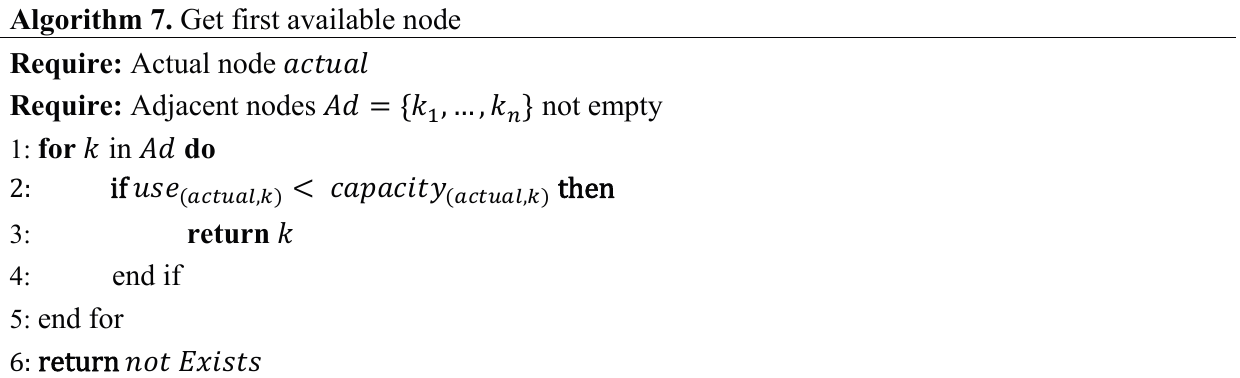
Algorithm 7. Get first available